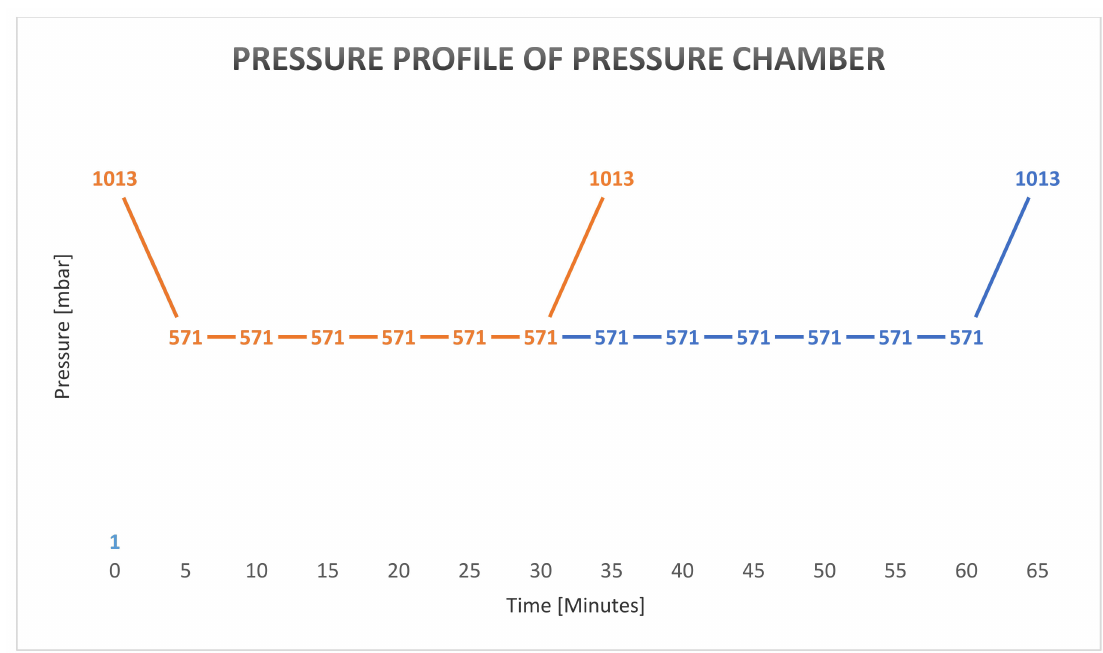
Figure 16. Pressure Profile of Pressure Chamber during Experimental Groups HH30 and